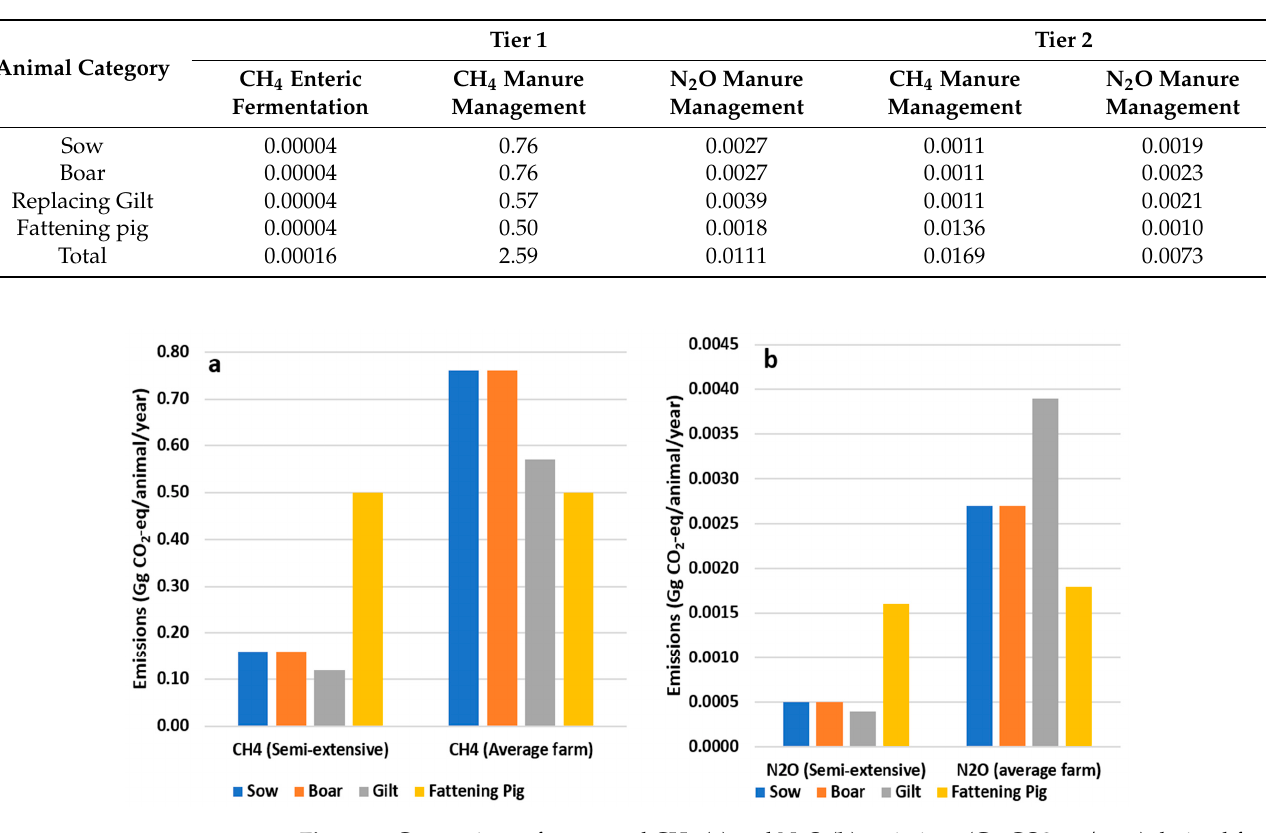
Figure 4. Comparison of computed CH 4 ( a ) and N 2 O ( b ) emissions (Gg CO2-eq/year) derived from manure management produced per pig on a semi-extensive Greek farm and an average Greek farm using Tier 1 methodology.